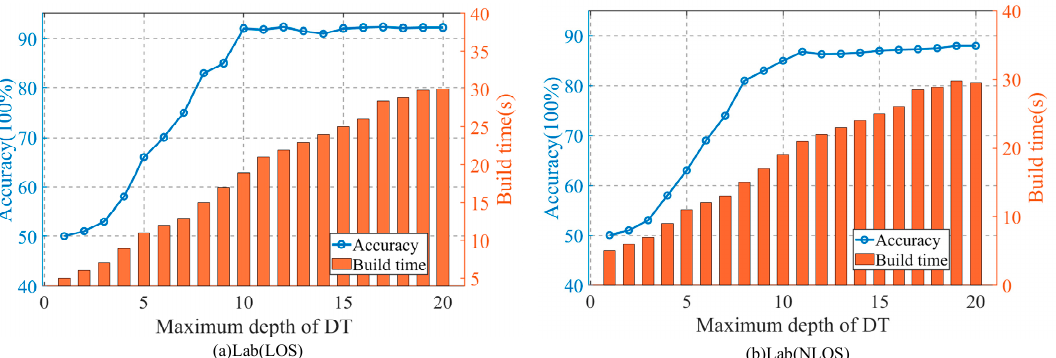
Figure 7. The impact of decision tree depth on the accuracy and construction time of the method. ( a ) Lab (LOS), ( b ) Lab (NLOS).